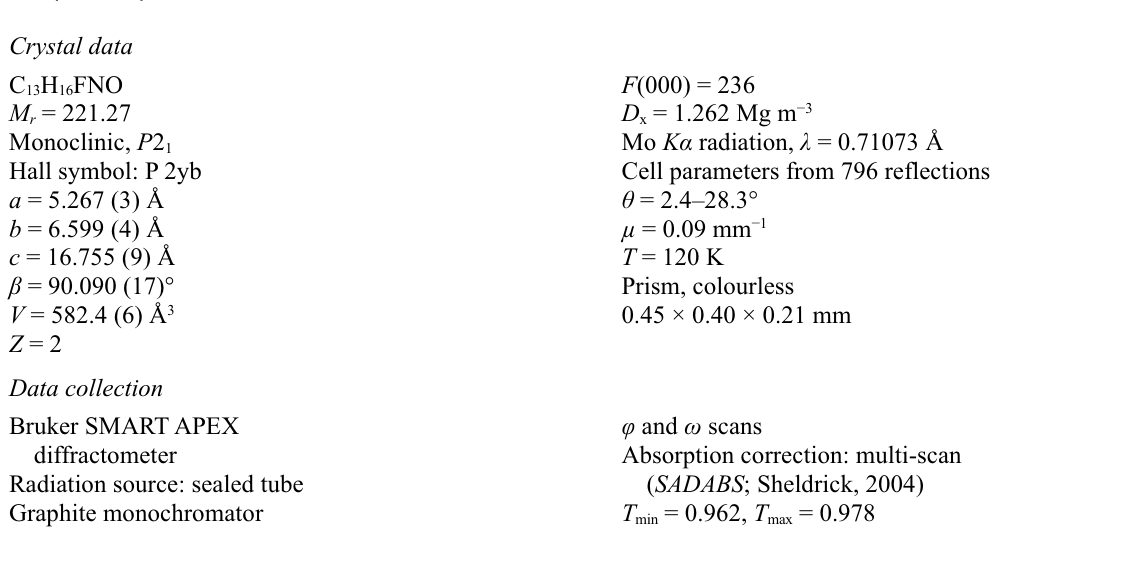
Crystal packing viewed along [100] with intermolecular N–H···O hydrogen bonding pattern indicated as dashed lines. H- atoms not involved in hydrogen bonding are